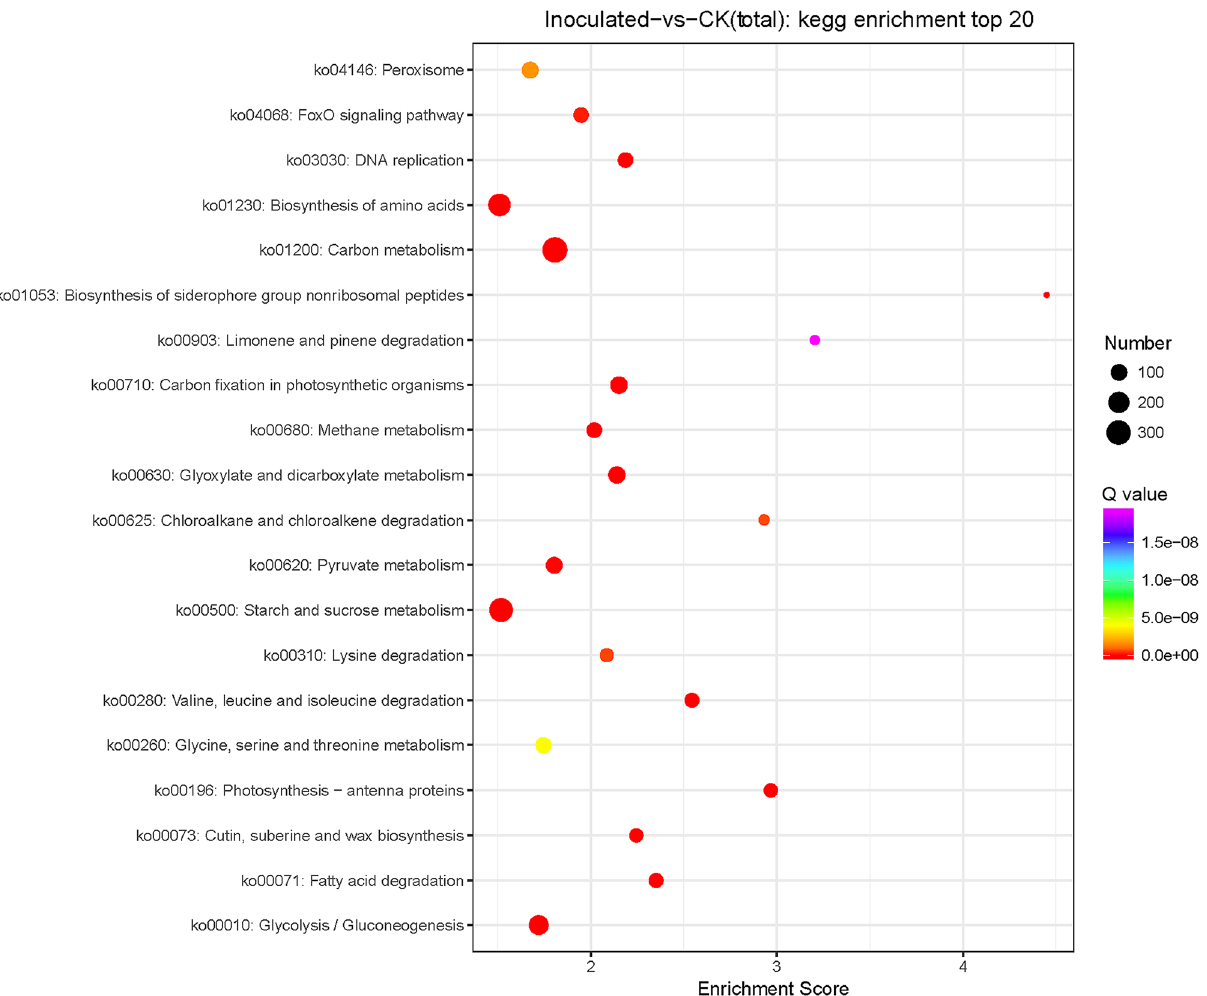
Figure 7. KEGG enrichment analysis scatter plot representing pathways of DEGs in response to T. controversa infection. The colours blue, white and red indicate low, medium, and high expression patterns of genes, respectively. CK indicates mock plants, and Inoculated indicates plants infected by T. controversa.